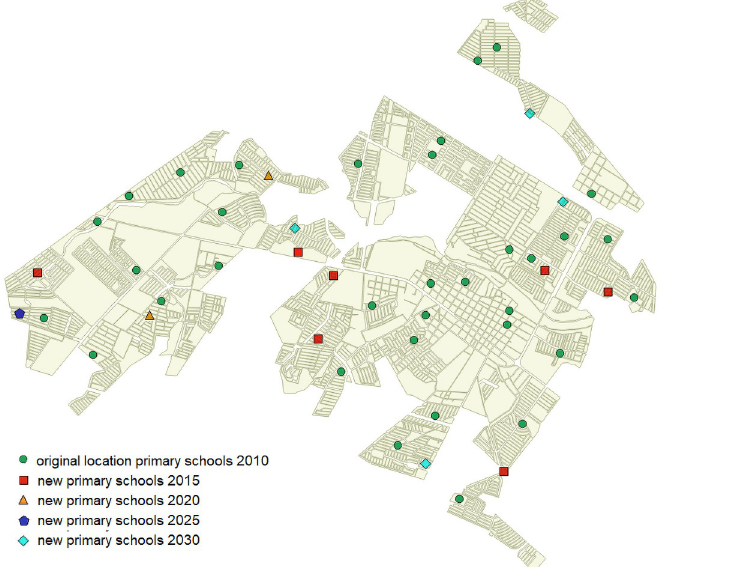
Fig 16. Location of the new schools throughout time periods.